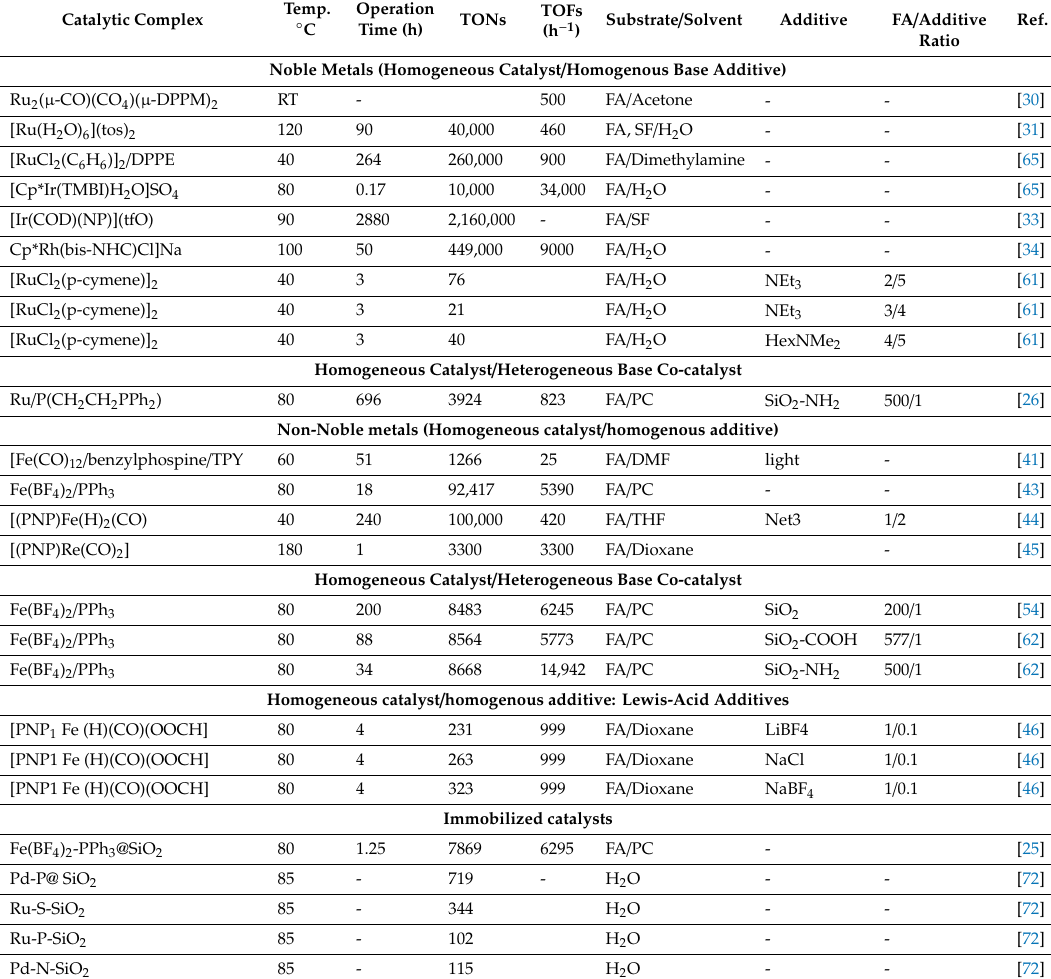
Figure 15. Covalent immobilization of Fe / PPh 3 catalyst and catalytic results obtained. Figure adapted from Reference [23]. Table 1. Representative catalytic systems used to FA